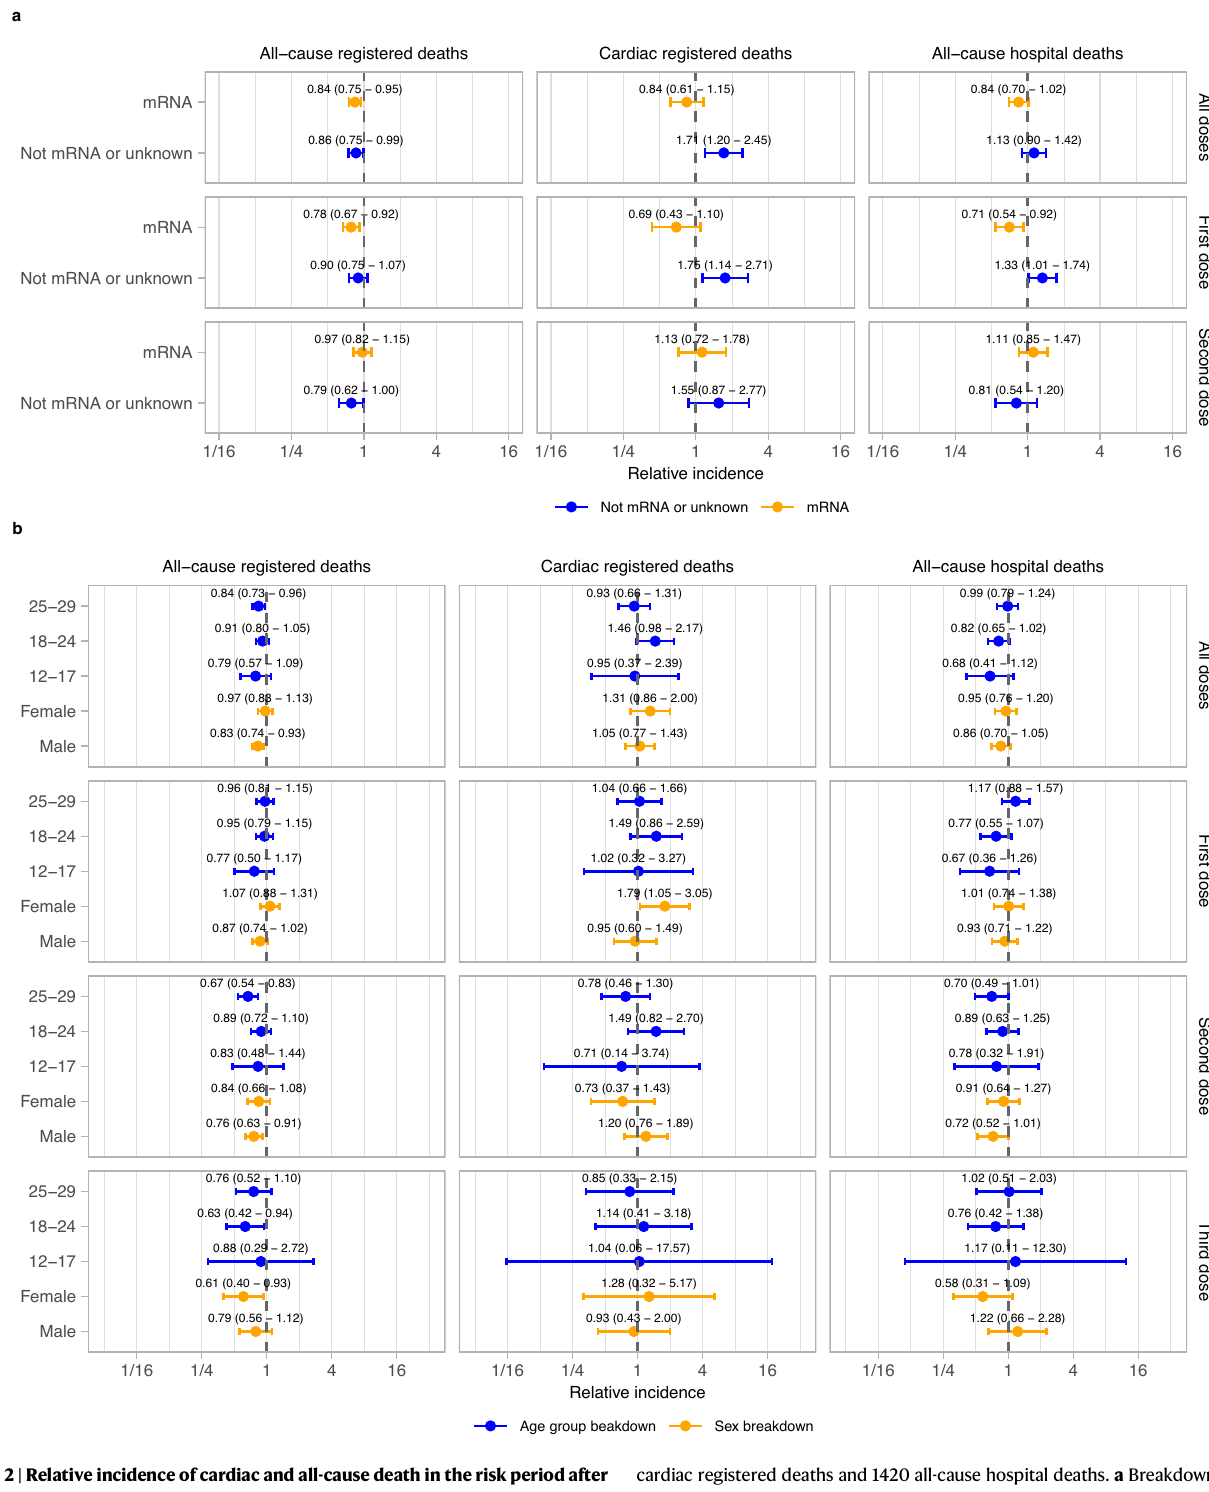
cardiac registered deaths and 1420 all-cause hospital deaths. a Breakdowns by vaccine vector b Breakdowns by sex and age-group. Results are not presented for the third dose because these are almost all mRNA